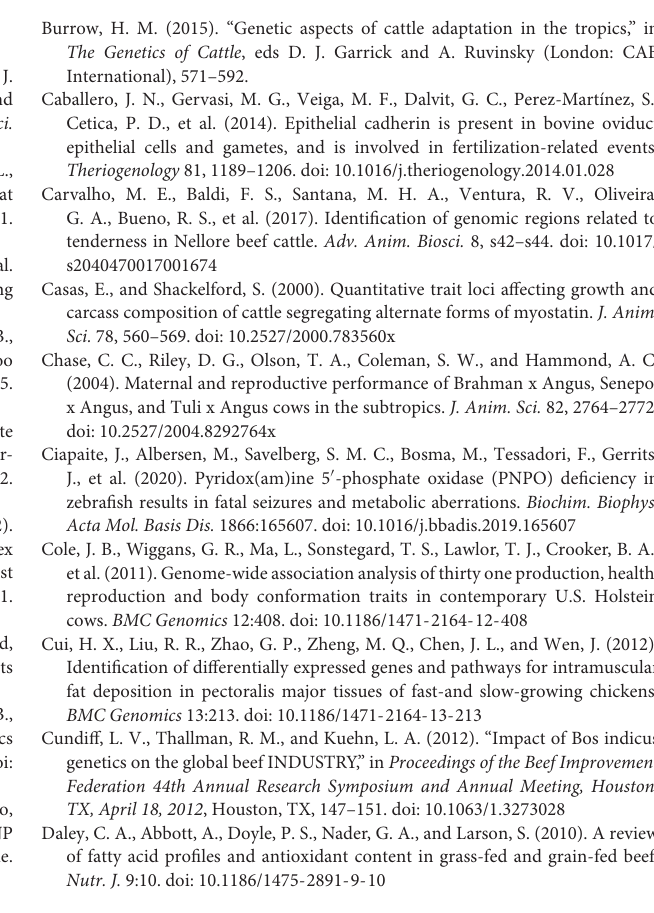
Supplementary Table 3 | The number of SNPs and additive genetic variance (%) explained in TEND by 1-Mb genomic windows from single-trait WssGBLUP analysis correcting for indirect effects where all other traits were included as covariates. Supplementary Table 4 | The number of SNPs and additive genetic variance (%) explained in JUIC by 1-Mb genomic windows from single-trait WssGBLUP analysis correcting for indirect effects where all other traits were included as covariates. Supplementary Table 5 | The number of SNPs and additive genetic variance (%) explained in FLAV by 1-Mb genomic windows from single-trait WssGBLUP analysis correcting for indirect effects where all other traits were included as covariates. Supplementary Table 6 | The number of SNPs and additive genetic variance (%) explained in COLOR by 1-Mb genomic windows from single-trait WssGBLUP analysis correcting for indirect effects where all other traits were included as covariates. Supplementary Table 7 | The number of SNPs and additive genetic variance (%) explained in TEXT by 1-Mb genomic windows from single-trait WssGBLUP analysis correcting for indirect effects where all other traits were included as covariates. Supplementary Table 8 | The number of SNPs and additive genetic variance (%) explained in FIRM by 1-Mb genomic windows from single-trait WssGBLUP analysis correcting for indirect effects where all other traits were included as covariates. Supplementary Table 9 | Genes located within the pleiotropic